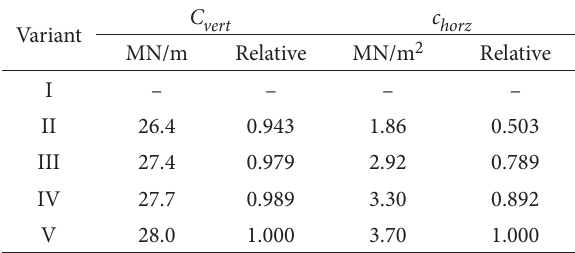
table 4. Vertical spring stiffness values under the piles and horizontal spring stiffness values along the piles Variant